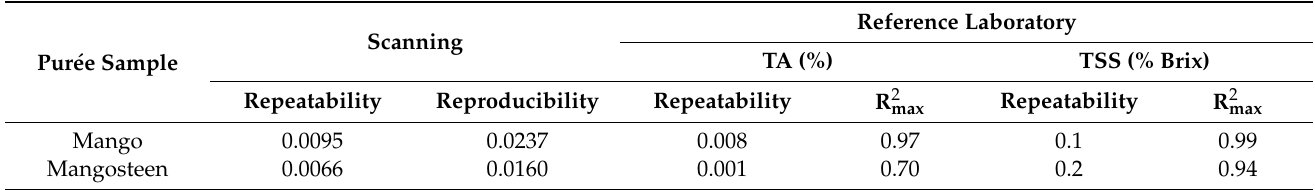
Table 1. Repeatability and reproducibility of scanning by FT-NIR, and R 2 max of the reference